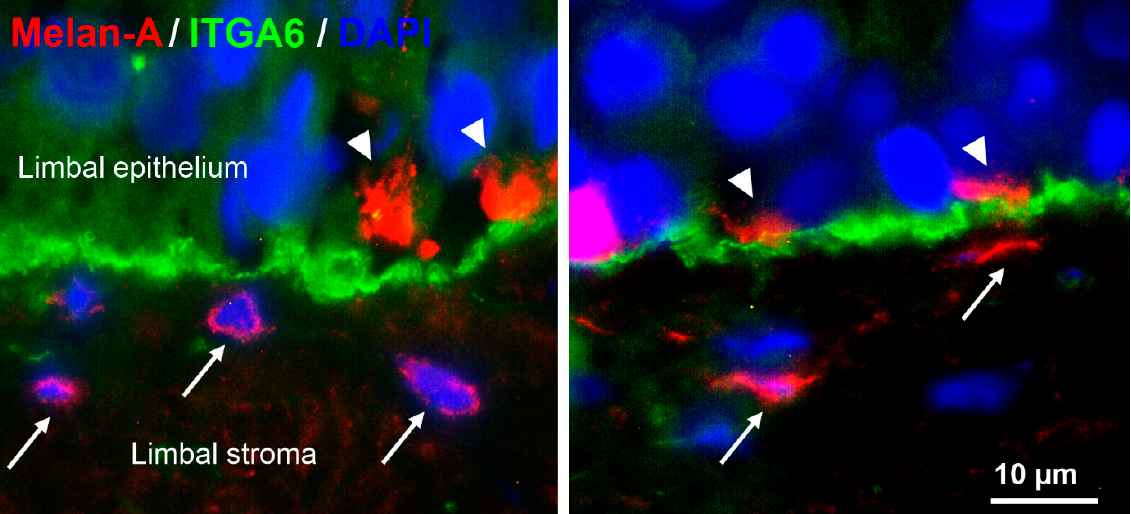
Figure 1. Localization of epithelial and stromal melanocytes at the human limbus in situ. Immunofluorescence double labeling of corneoscleral tissue sections prepared from two donor corneas (age 65 and 72 years) showing Melan-A + melanocyte processes (arrowheads) in the basal limbal epithelium expressing integrin α 6 (ITGA6) and additional Melan-A + melanocytes (arrows) in the subepithelial limbal stroma; nuclear counterstaining with 4 ′ ,6 - diamidino - 2 - phenylindole (DAPI).